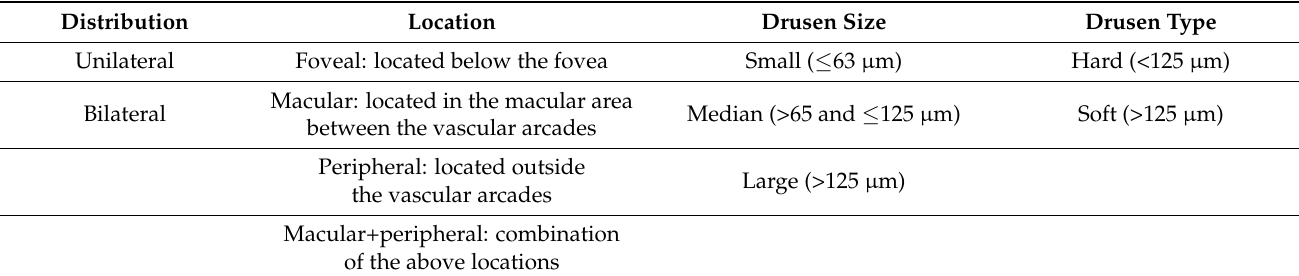
Table 1. Classification of drusen according to the protocol of Ruiz et al.